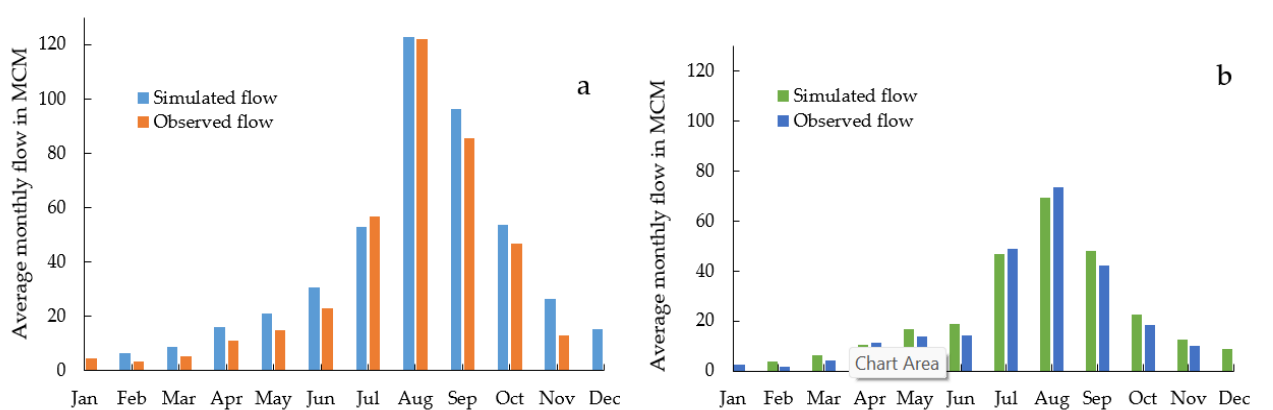
Figure 9. Monthly long-term average flow of observed vs. simulated Katar ( a ) and Meki ( b ) sub-